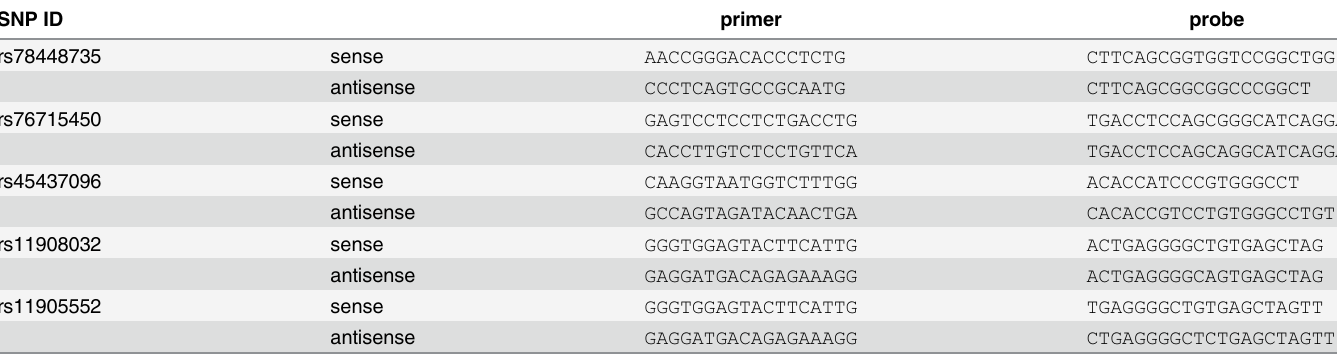
Table 4. Primers sets and probes for TaqMan assays.